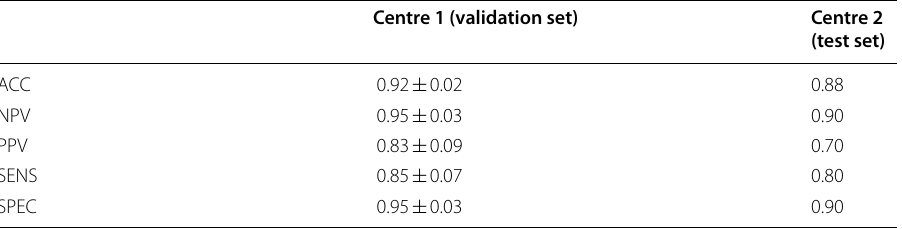
Table 4 Performance results in centre 1 (mean top 10 best-performing